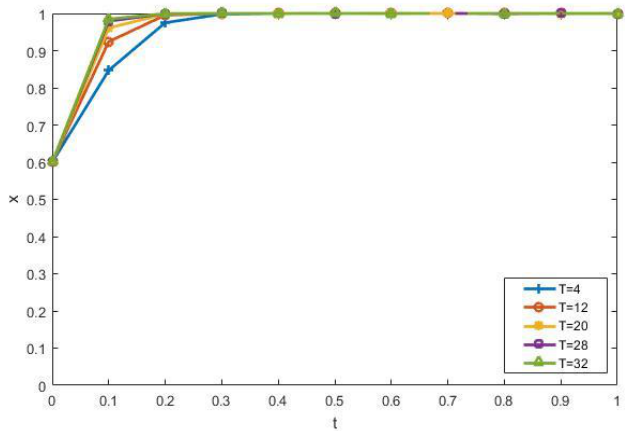
Figure 9. The impact of T on the evolutionary results.